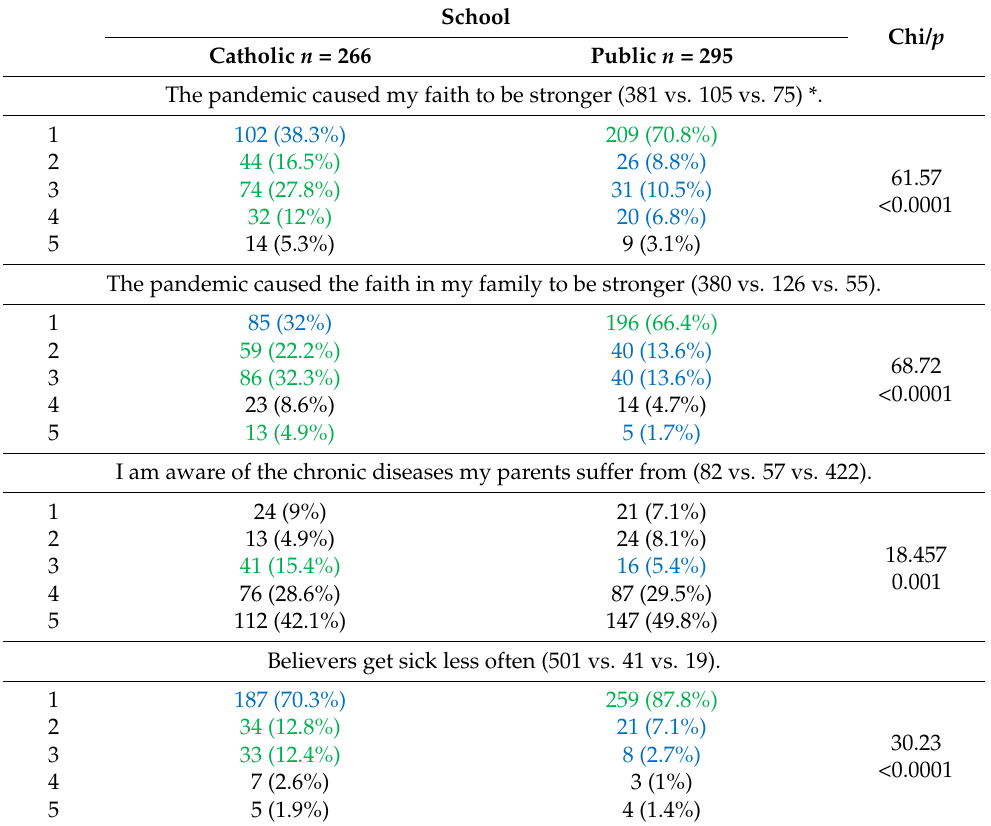
Table 2. Comparison of responses to questions about religion, the pandemic, and health issues between Catholic and public high school students. School Chi/ p Catholic n = 266 Public n = 295 The pandemic caused my faith to be stronger (381 vs. 105 vs. 75)